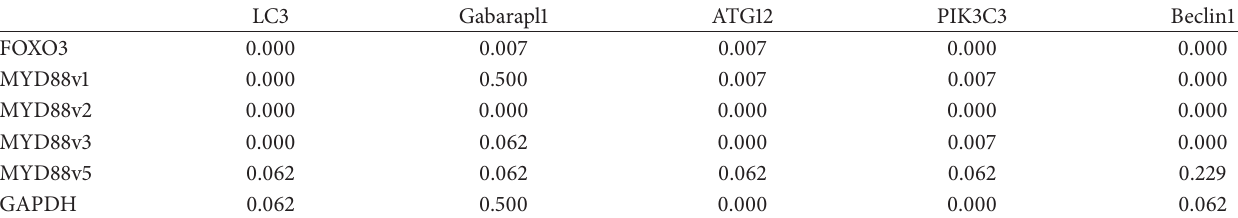
Correlations were considered significant when 𝑃 < 0.01 .